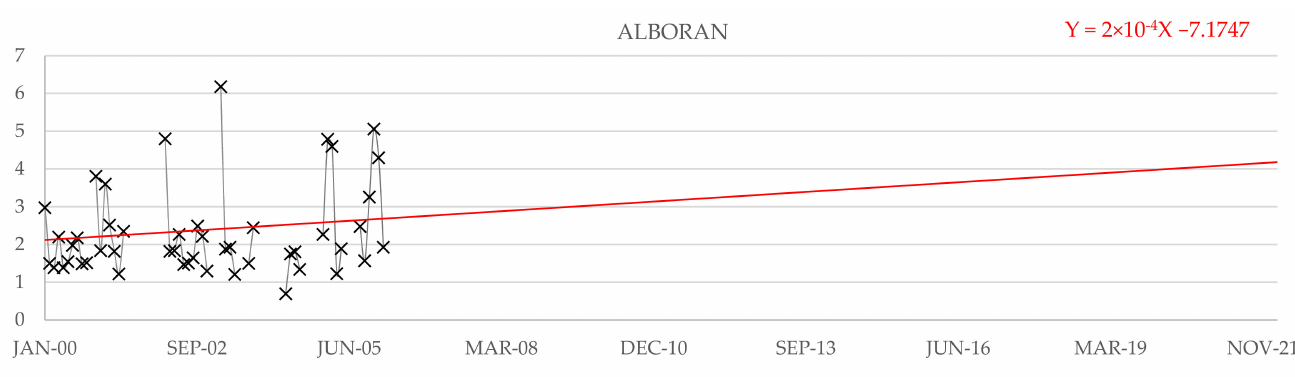
Figure 4. Evolution of Hs maxima in